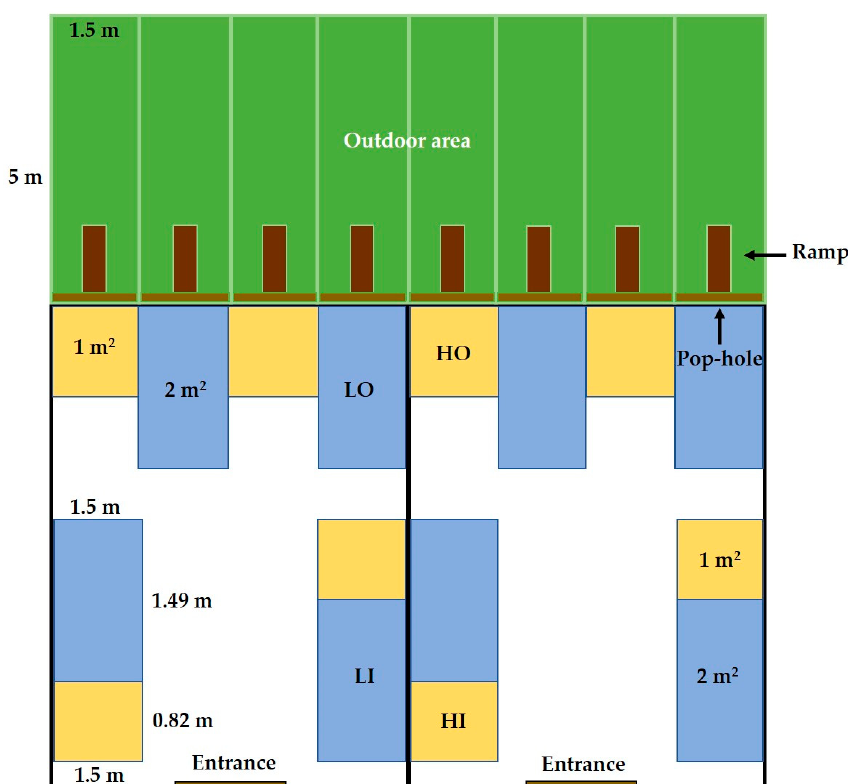
Figure 1. Experimental poultry facilities. Dimensions of pens include the supplementary space added to compensate for the area occupied by feeder and drinker. LO = Low stocking density with outdoor access; HO = High stocking density with outdoor access; LI = Low stocking density indoors; HI = High stocking density indoors.